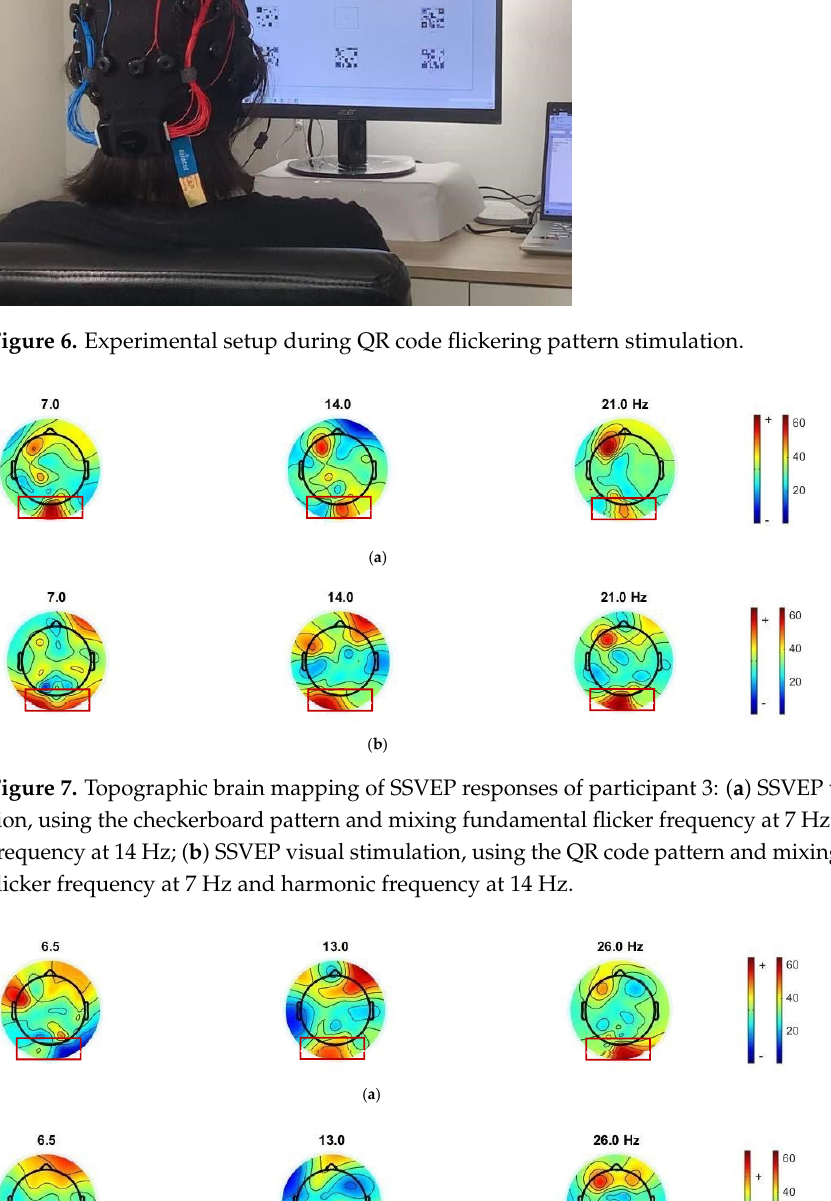
Figure 6. Experimental setup during QR code flickering pattern stimulation.